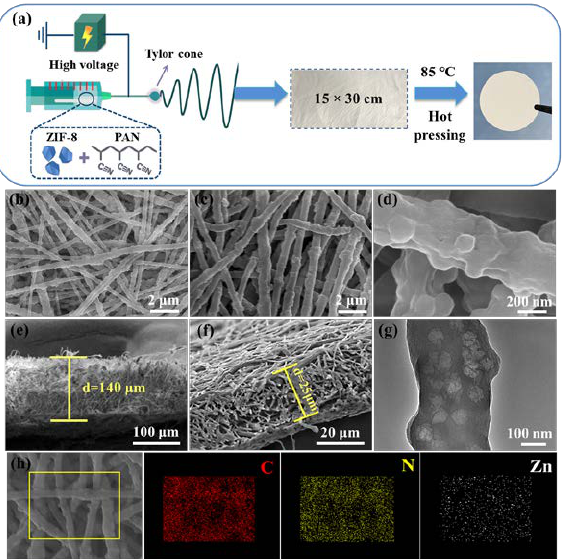
Figure 2. ( a ) Fabrication diagram and optical photograph of ZIF8-PAN separator. The SEM images of ZIF8-PAN composite membrane before hot-pressing: ( b ) top-view, ( e ) cross-section; after hot-pressing: ( c , d ) top-view; ( f ) cross-section. ( g ) TEM image of ZIF8-PAN separator. ( h ) EDS element mapping distribution of ZIF8-PAN separator.